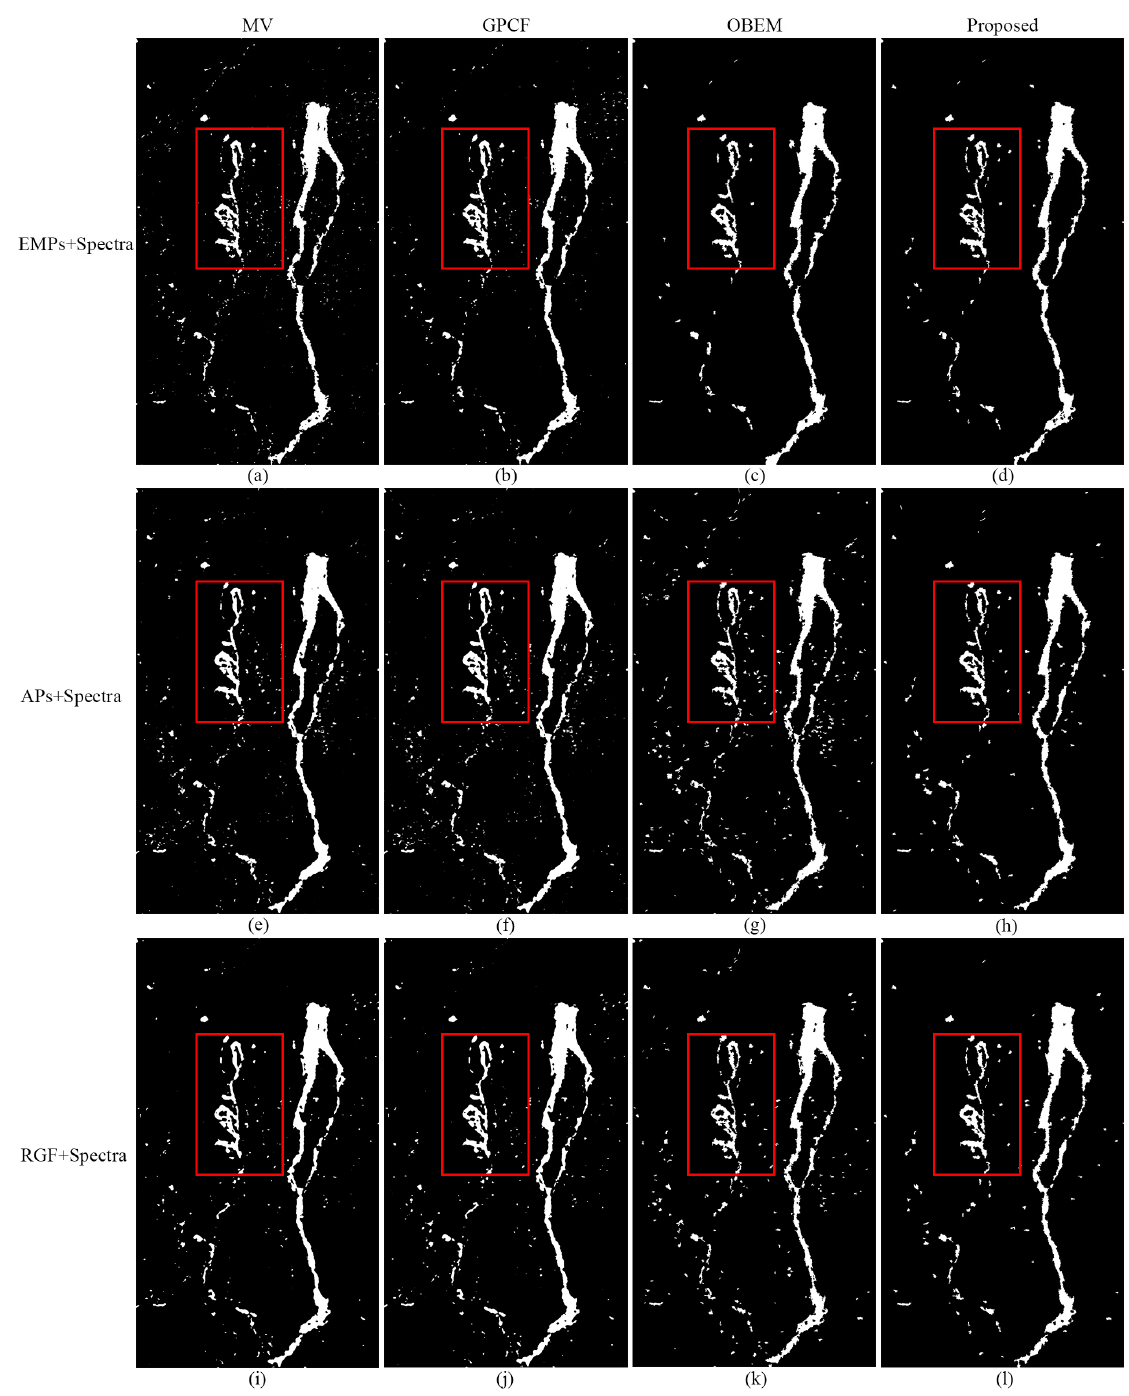
Figure 9. Visual comparison of the detection maps between the post-processing and the proposed approaches with different spatial–spectral feature fusion methods in the Site B landslide aerial images. The caption on the left shows which spatial–spectral feature was adopted in this row, and the caption at the top shows which post-processing approach the column adopted.